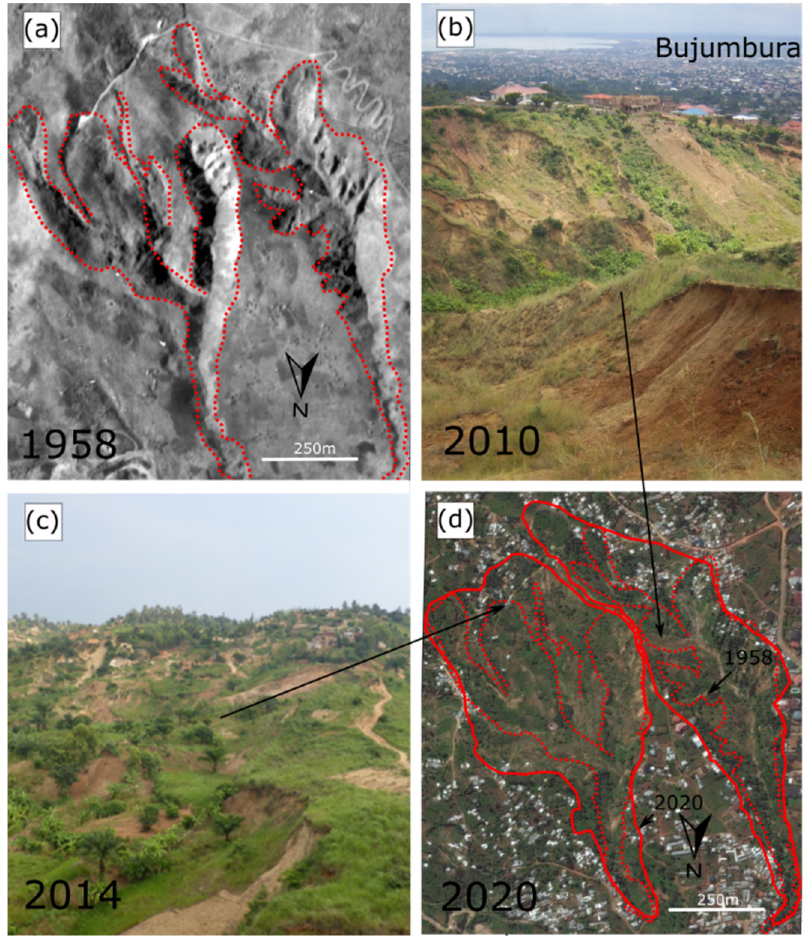
Figure 7. Example of two gullies with landslide processes, located within a densely populated outskirt of Bujumbura ( − 3.384 ◦ , 29.395 ◦ ). The image sequence illustrates the rapid evolution of the gullies and the built-up area between 1958 to 2020. ( a ) Historical orthomosaic from 1958; ( b ) recent photo of the gully at the right (©Alexis Ciza); ( c ) recent photo of the large landslide that develop in the gully at the left; ( d ) ©Google Earth image from 28 January 2020. The dotted lines represent the limits of the gullies in